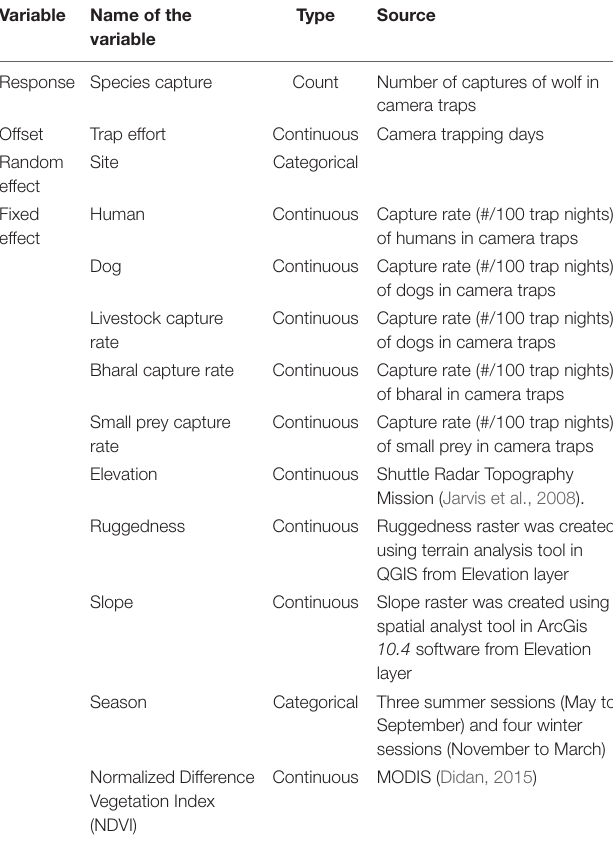
TABLE 2 | Description of the variables used in the generalized linear mixed models used to understand the response of the woolly wolf to habitat and anthropogenic factors in the Nelang valley of the Gangotri National Park, Uttarakhand,